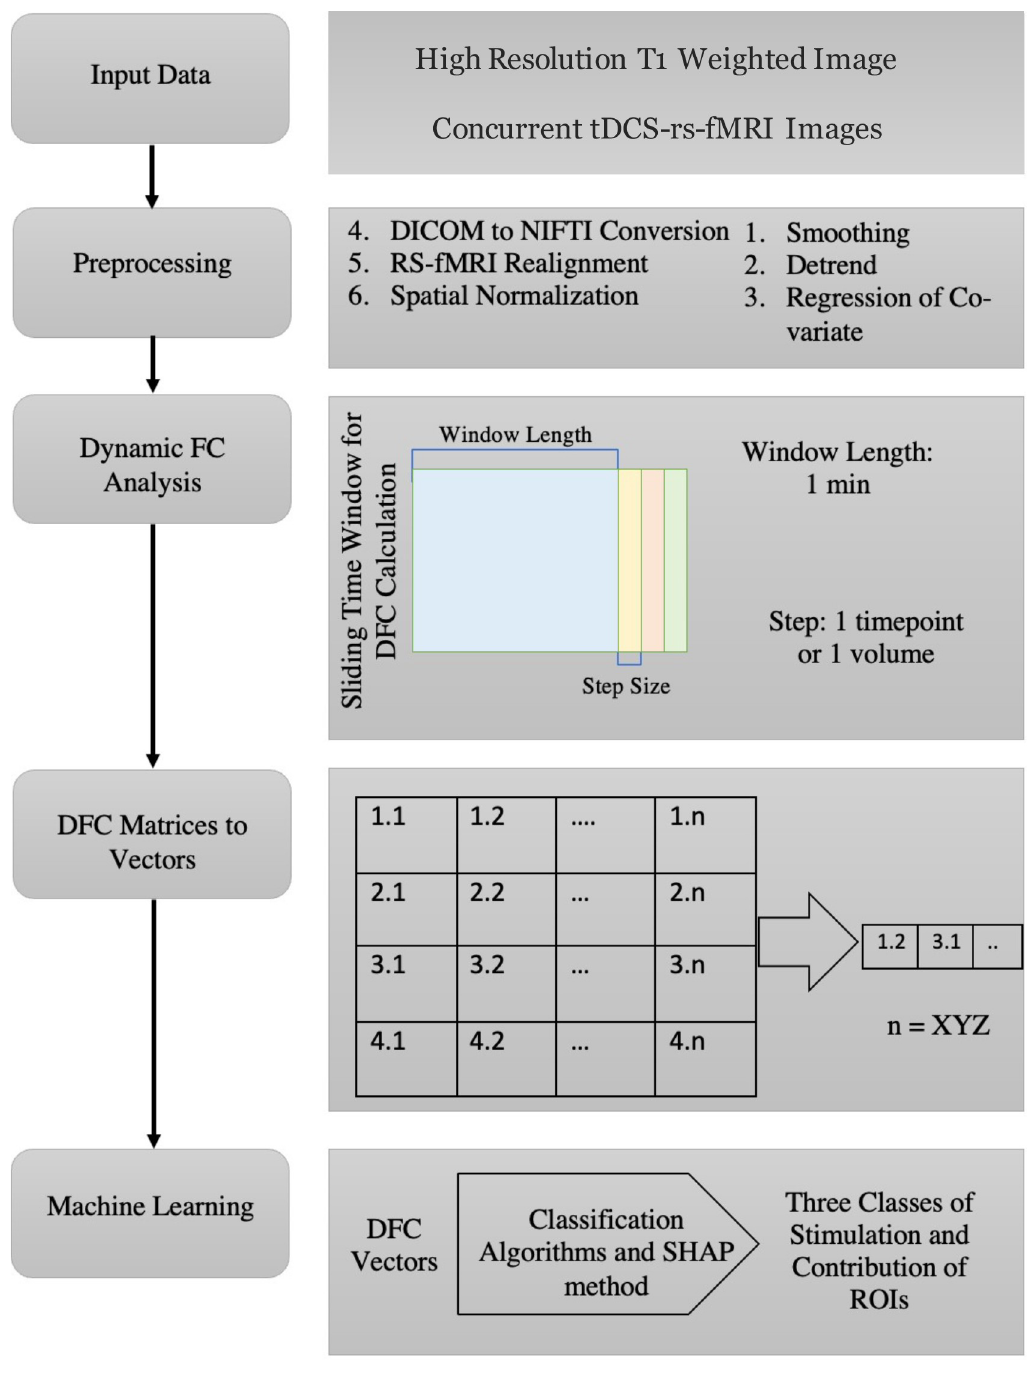
Fig 3. Data preprocessing